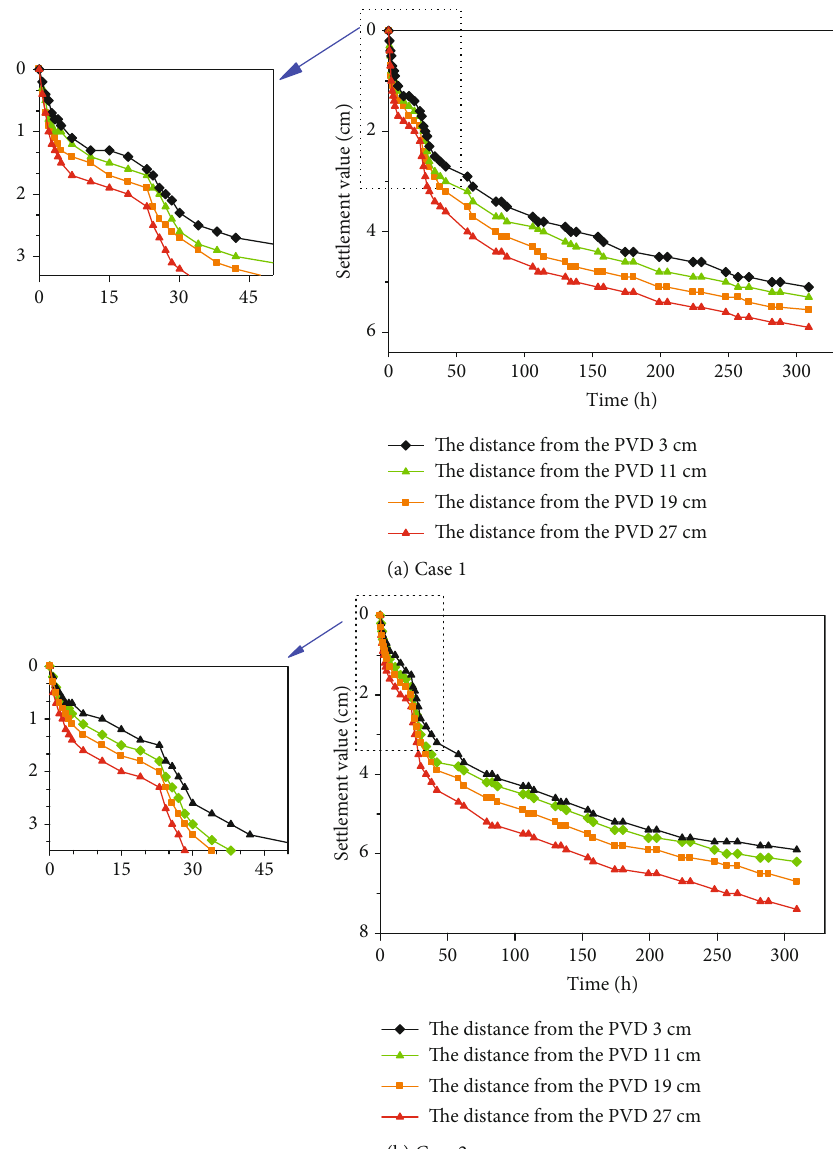
Figure 10: Settlement law of the monitoring